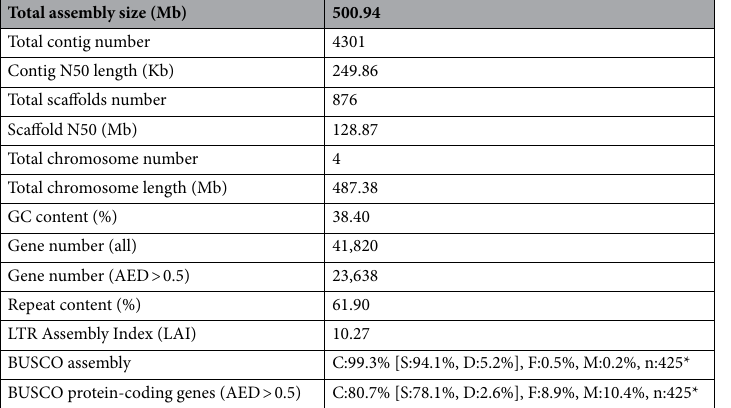
(Fig. 2). The statistics for repeat content (61.90%, Supplementary File 1: Table S3) and proportion of total gene